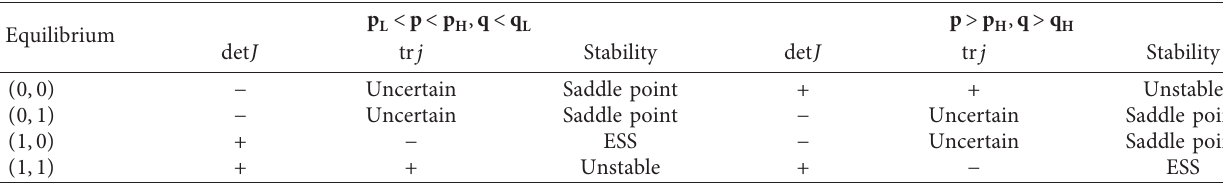
Table 4: Equilibrium point local stability.